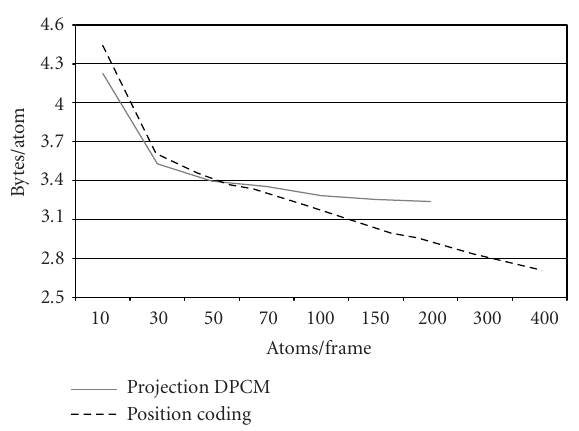
Figure 3: Bytes per atom necessary to code 19 frames of Container QCIF using di ff erent encoding